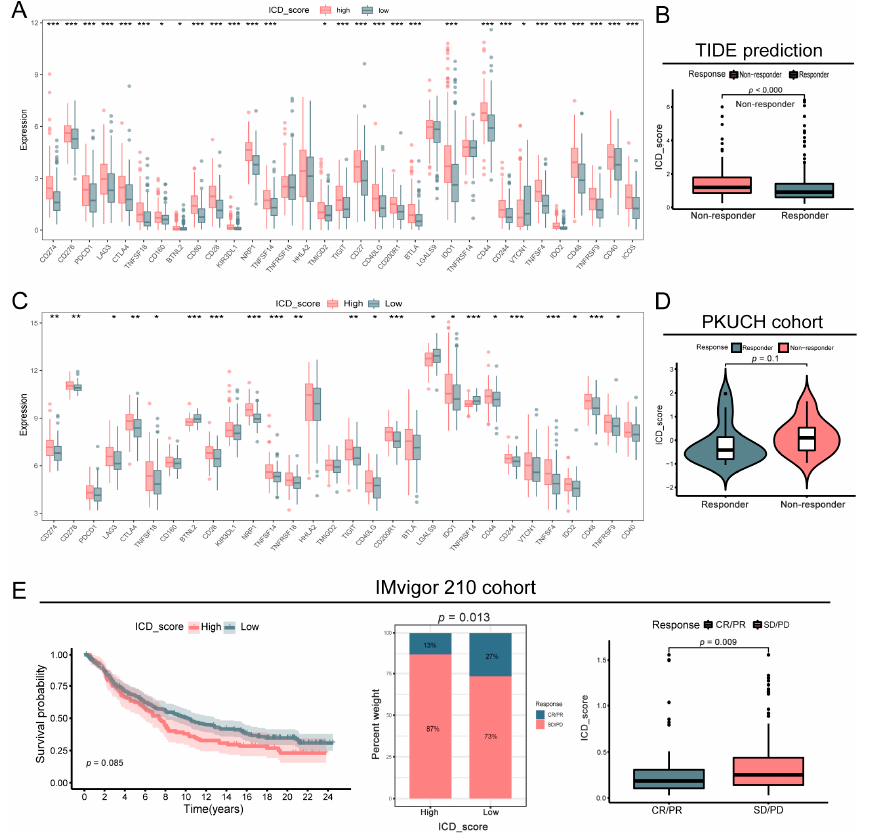
Figure 8. Association of ICD_csore with response to treatment. ( A ) Expression of immune checkpoints in the high- and low-ICD_score groups in TCGA cohort. ( B ) TIDE analysis showed the difference in predicted TIDE scores between two ICD_score patterns in TCGA cohort. ( C ) Expression of immune checkpoints in the high- and low-ICD_score groups from our PKUCH cohort ( n = 198). ( D ) The differences of ICD_score in responders and non-responders to chemotherapy in a PKUCH cohort ( n = 35). ( E ) Association of ICD_score with immunotherapy response in IMvigor210 cohort. p values were shown as: * p < 0.05; ** p < 0.01; *** p < 0.001. CR, complete response; PR, partial response; SD, stable disease; PD, progressive